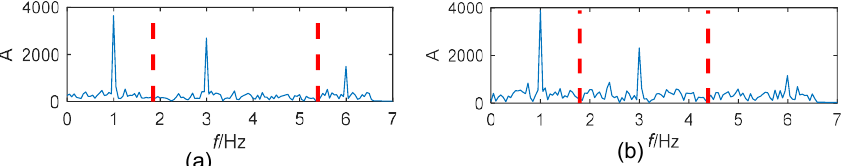
Figure 5. Segmentation of the Fourier spectrum for signals with an SNR of: ( a ) –6 dB; ( b ) –10 dB.